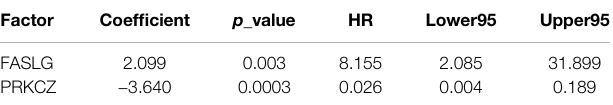
TABLE 3 | Multivariate Cox regression